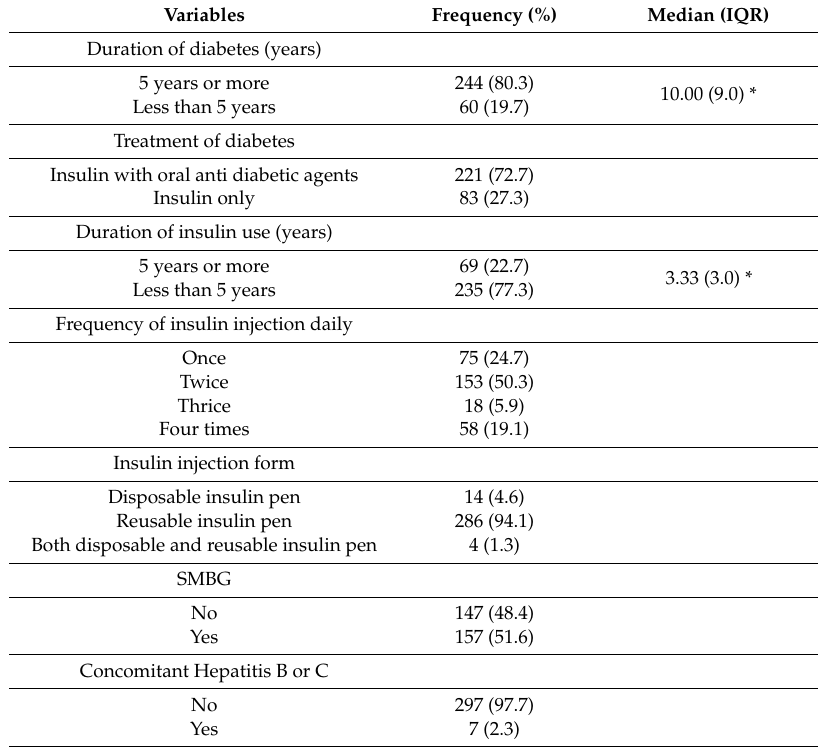
Table 2. Diabetes and diabetic characteristics of Type 2 diabetic patients on insulin ( n = 304).